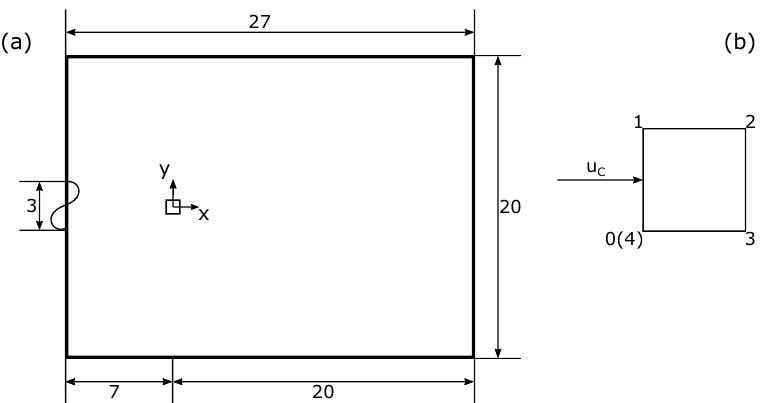
Figure 1. ( a ) Computational domain and the dimensions normalised by the side length of cylinder D ; ( b ) Definition of circumferential direction of a cylinder section. The coordinate origin is placed on the centre of the cylinder.